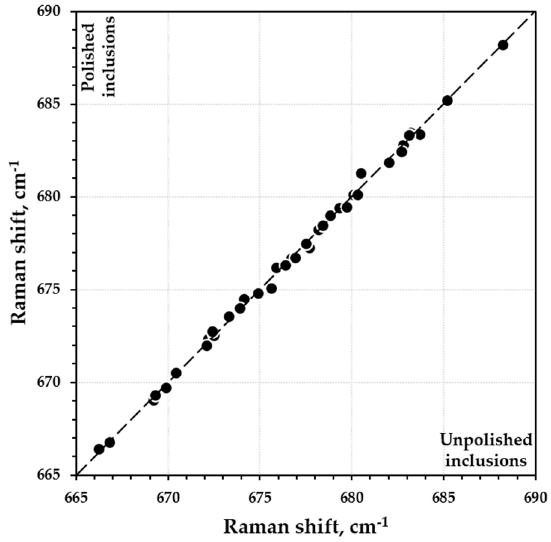
Figure A1. The convergence of the peak positions of stretching Si-O-Si br mode ( ν 11 ) for clinopyroxene inclusions in studied diamonds before and after polishing.